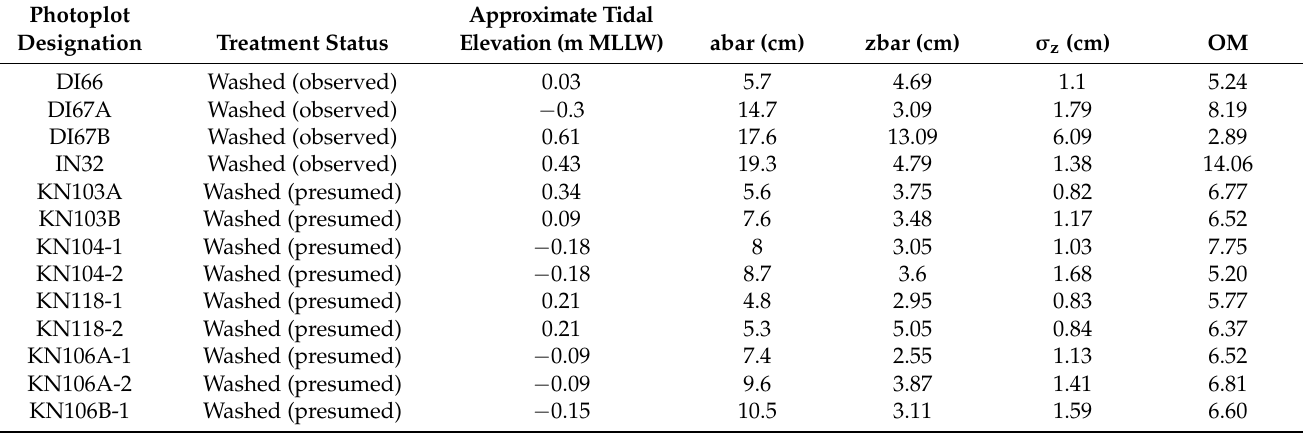
Table 2. Treatment status, tidal elevation, mean plot clast dimensions from Wolman Counts (abar), key photoplot-metrics (average and standard deviations of plot elevations [z values]), and calculated organization metric (OM) values for surficial sediments at study plots in western Prince William Sound beaches. Sites ordered from north (Disk Island) to south (Latouche Island). Sites indicated with “ − 1” and “ − 2” in the designation ID are for those beaches with considerable longshore diversity in clast size, where duplicate photoplots were analyzed. Variance measures: a standard